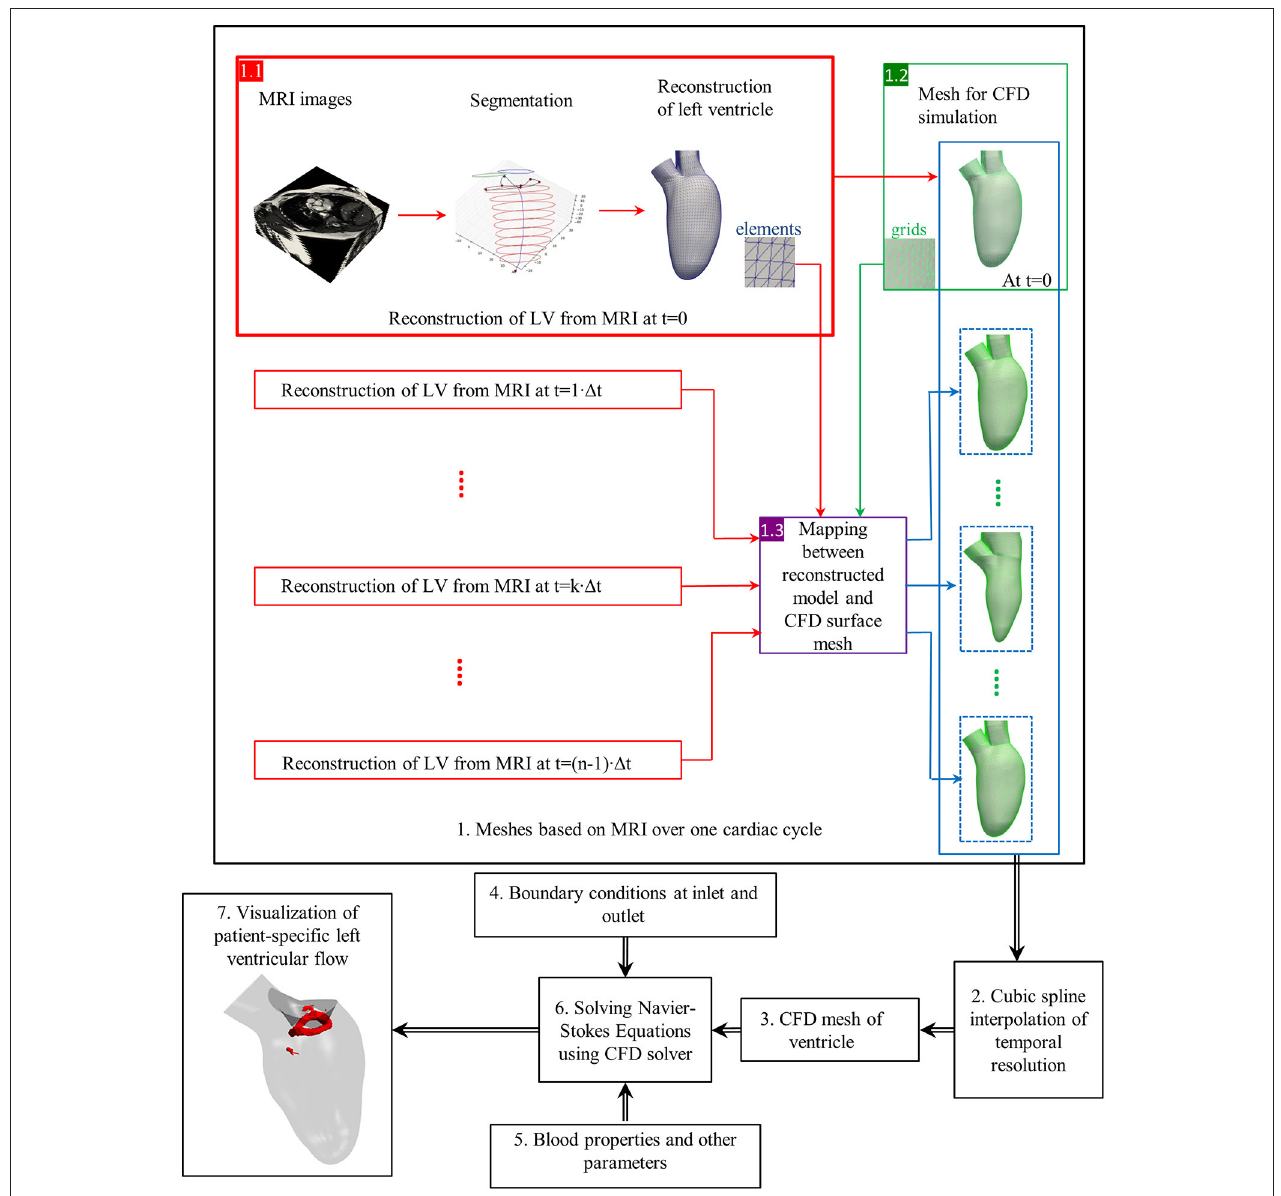
FIGURE 4 | Flow chart of CFD simulation of patient-specific intra-cardiac flow. Black box: each step of numerical simulation (Su et al., 2016). Red box: left ventricle reconstruction from MRI images. Green box: CFD mesh generation. Violet box: Mapping between reconstructed model and CFD surface mesh. Dotted blue box: CFD mesh resulted from mapping. Blue box: A series of CFD meshes at each frame. Elements (blue) and grids (green) are for reconstructed geometry and CFD mesh,